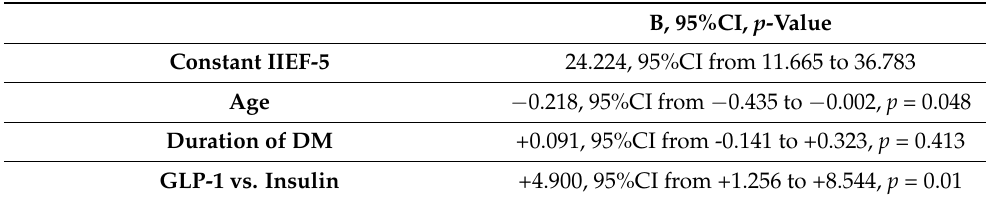
Figure 2. IIEF-5 score according to antidiabetic treatment group. DPP4i = dipeptidyl-peptidase-4 inhibitors; GLP-1a = glucagon-like peptide-1receptor agonists; SGLT2i = sodium-glucose cotransporter-2; SU = sulfonylureas; IIEF = International Index of Erectile Function . Table 2. Linear regression analysis outlining the increase in IIEF-5 score among patients treated with GLP-1 vs. patients treated with insulin, adjusted for age and duration of diabetes mellitus